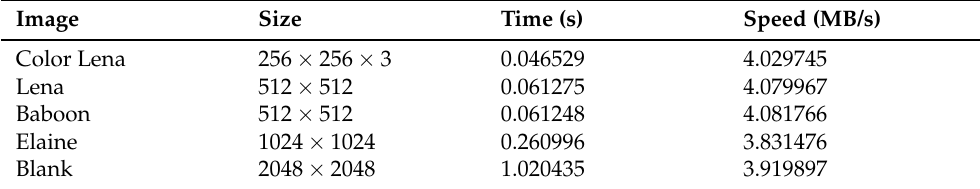
Table 2. The running times for generating cipher images using the proposed